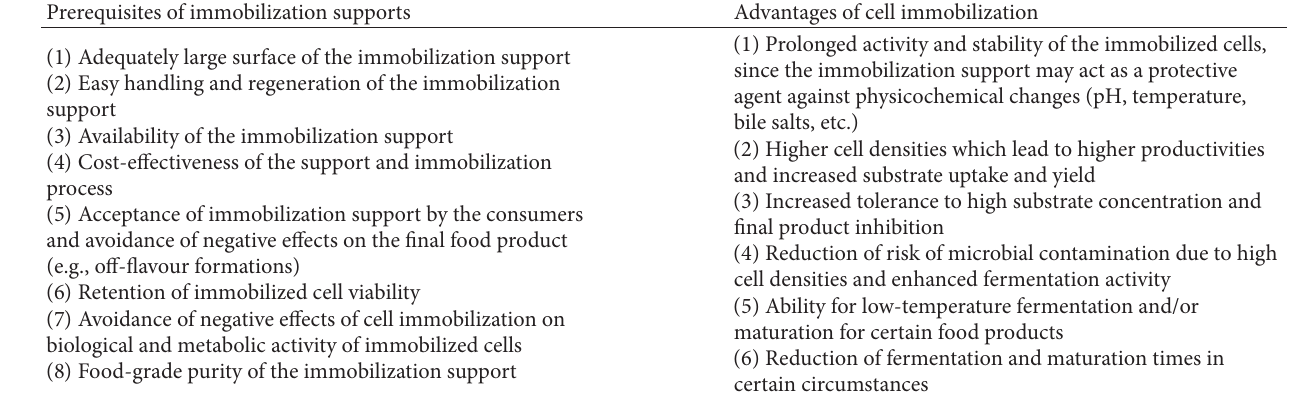
Table 4: Prerequisites of immobilization supports and advantages of cell